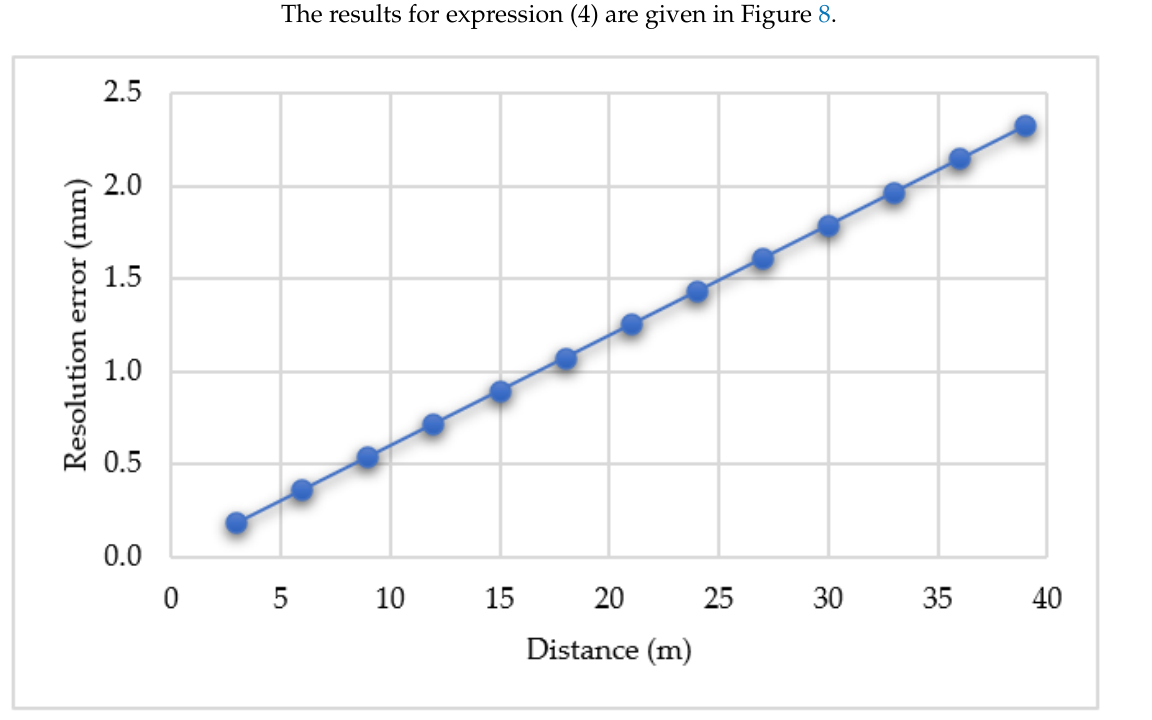
Figure 8. The graph of the resolution